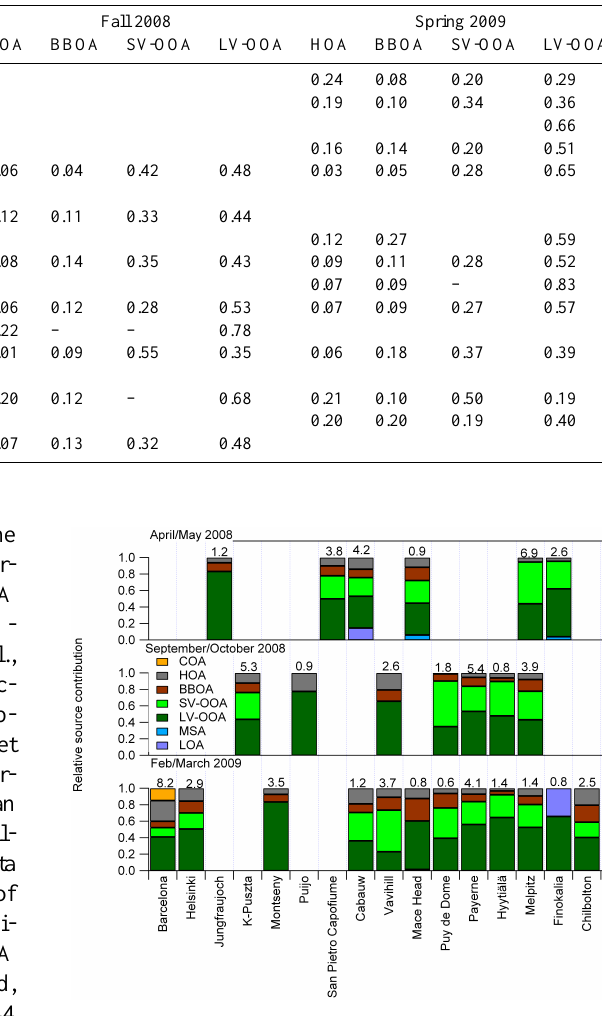
Figure 4. Relative organic source contributions (ME-2 results). On top of each bar the average organic concentration (in µgm − 3 ) is also reported. Site specific sources are classified as LOA (local organic aerosols) and include HULIS-related OA (humic-like substances) for Cabauw (Paglione et al., 2013), while amines and local sources for Finokalia (Hildebrandt et al.,